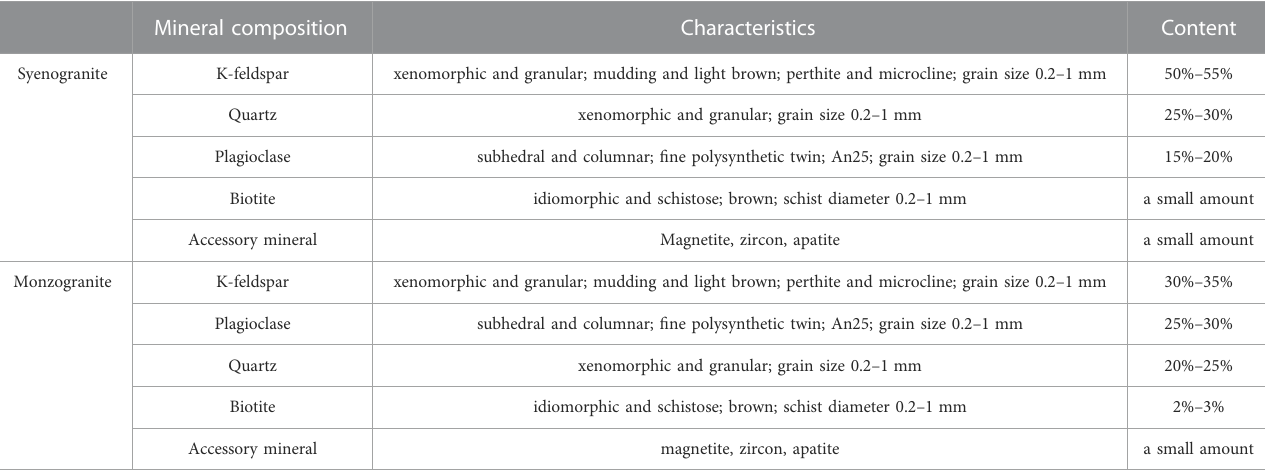
TABLE 1 Petrographic characteristics of syenogranite and monzogranite in the study area. Mineral composition